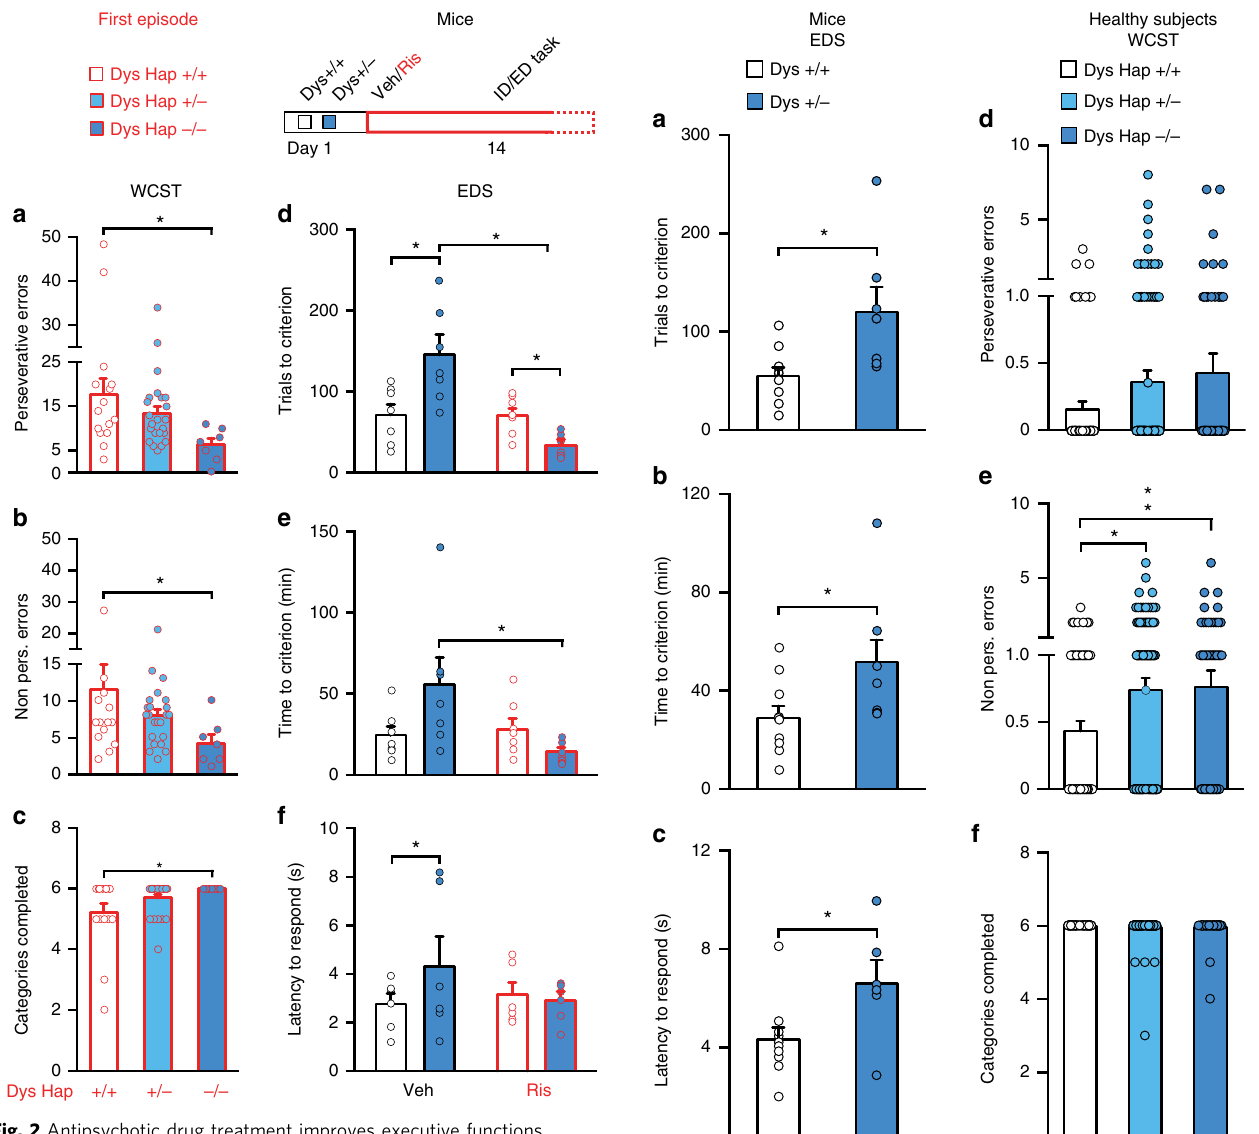
Fig. 3 Variations in dysbindin-1 modulate cognition in opposite manner in drug-naive subjects compared to patients with schizophrenia. a , b Dys + / − mice ( n = 7, dark blue bar) needed ( a ) more trials (one-way ANOVA, genotype effect, F (1, 15) = 7.69, p < 0.05) and ( b ) more time than + / + mice (one-way ANOVA, genotype effect, F (1, 15) = 7.69, p < 0.05) to complete the EDS of the ID/ED Operon Task ( n = 10, white bar). c Increased latency to respond during the EDS in Dys + / − mice (one-way ANOVA, genotype effect, F (1, 30) = 8.43, p < 0.05). d , e Dys Hap + / − and − / − healthy volunteers (light and dark blue bar, respectively) made ( d ) similar perseverative errors (one-way ANOVA, F (2, 311) = 1.64, p = 0.19; n = 314) but ( e ), more non-perseverative errors (one-way ANOVA, F (2, 311) = 2.94, p = 0.05) on the WCST than Dys Hap + / + subjects (white bar). f The number of categories passed on the WCST was similar between groups (one-way ANOVA, F (2, 311) = 0.90, p = 0.41). Error bars represent S.E.M. whether a similar effect could be observed in the human brain, we analyzed the gene expression of D2 receptor isoforms in a sample ( n = 101) of DLPFC tissue from patients with schizophrenia. As in mice, we found that the D2S/D2L ratio was increased in Dys Hap − / − patients if and only if antipsychotic treatments could be